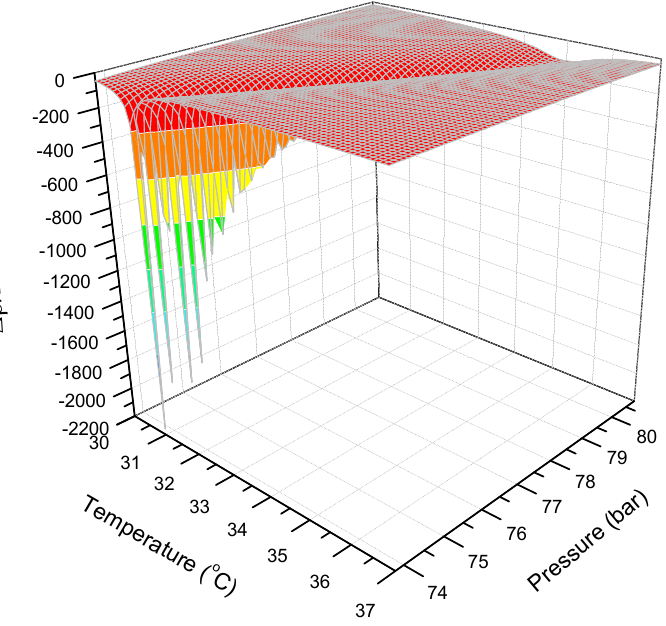
Figure 11. Density gradient of CO 2 with respect to temperature.